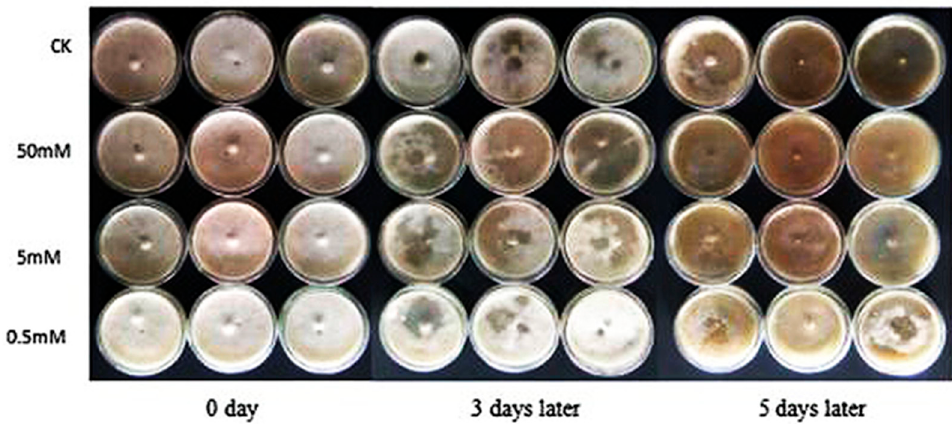
Figure 1. Effect of rapamycin on the pine wood nematode (PWN) inoculated onto B. cinerea . The nematodes treated by ddH 2 O control solution (CK) and 50, 5, and 0.5 mM rapamycin were grown in B. cinerea .